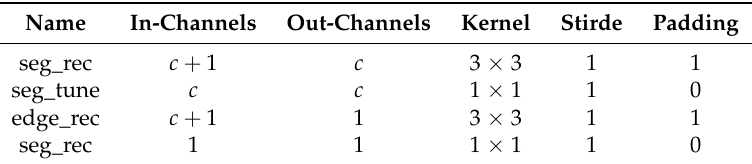
Table 1. Parameters of the four convolution